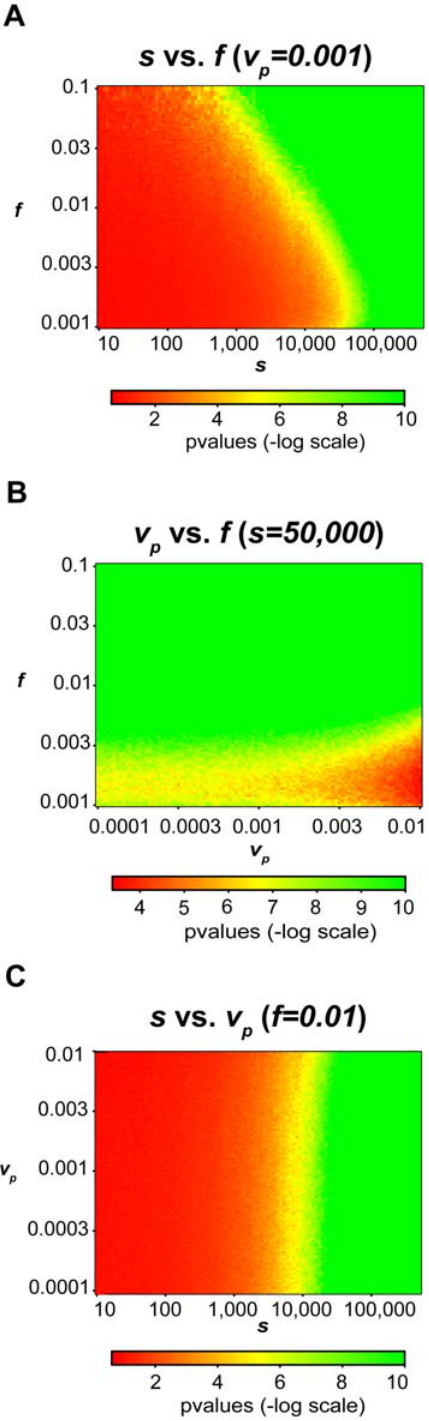
Figure 2. Simulation Results. Using 1423 Wellcome Trust 58C individuals, we give log scaled p-values for simulations based on three variables: the number of SNPs ( s ), the fraction of the individual in the mixture ( f ), and the probe variance ( v p ). The graphs plot the relationships between the three variables with a different variable fixed in each graph. The log scaled p-values are represented by the color of each point in the graph, as well as the z-axis on the right graphs. These simulations suggest that we should be able to resolve mixtures where a given individual is 0.1% of the mixture ( f ), probe variance is at most 0.01 ( v p ) and the number of SNPs probed is 50,000 ( s ).